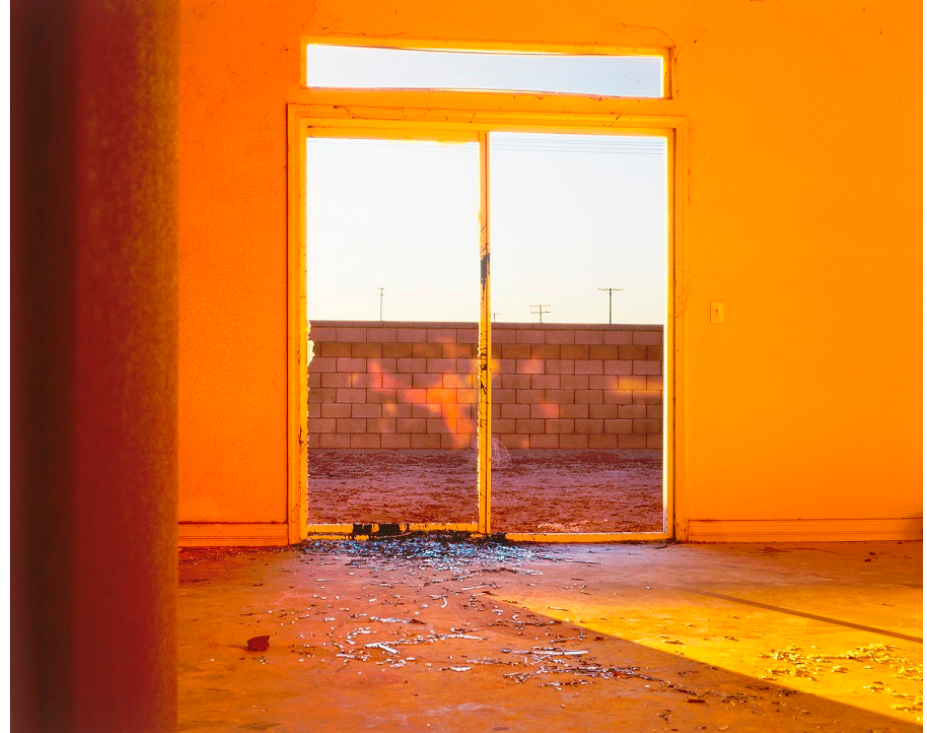
Figure 32. Anthony Hernandez, Discarded #50 (2014), © Anthony Hernandez.